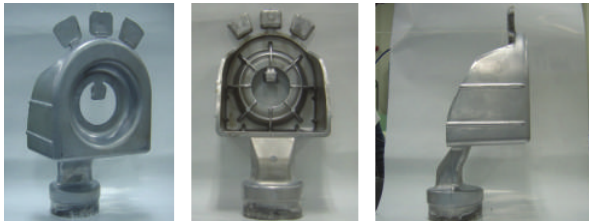
Figure 11: A photograph of products fabricated by vertical type squeeze machine ( V L = 0 . 1m/sec V H = 1 . 0m/sec, Solid fraction: